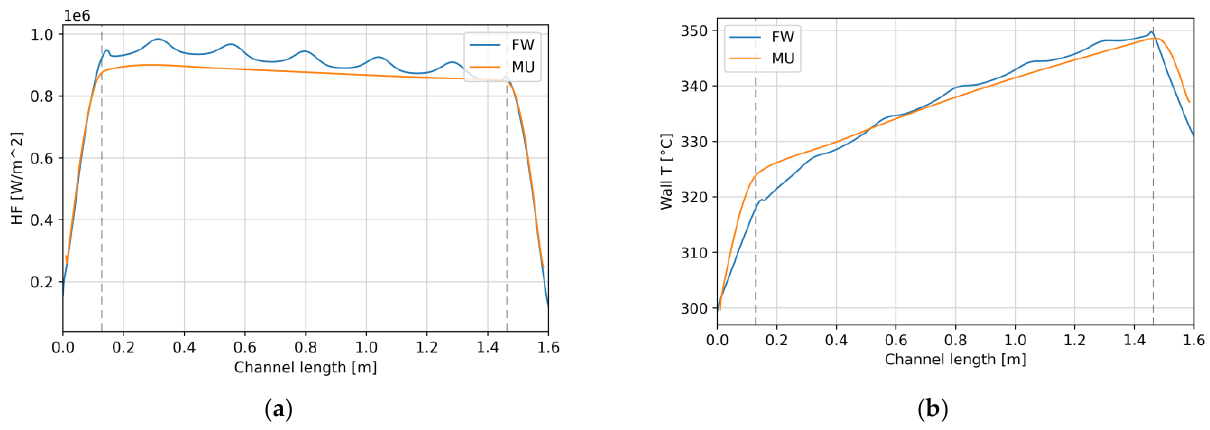
Figure 5. Wall-to-liquid HF ( a ) and wall temperature ( b ) along the front-side-wall center of a refer- ence channel.